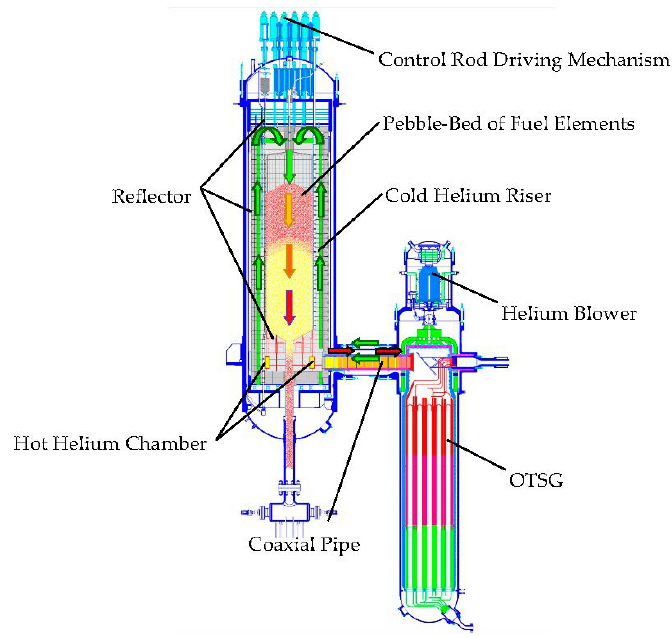
Figure 1. Schematic view of a modular high temperature gas-cooled reactor (MHTGR)-based nuclear steam supplying system (NSSS) module.